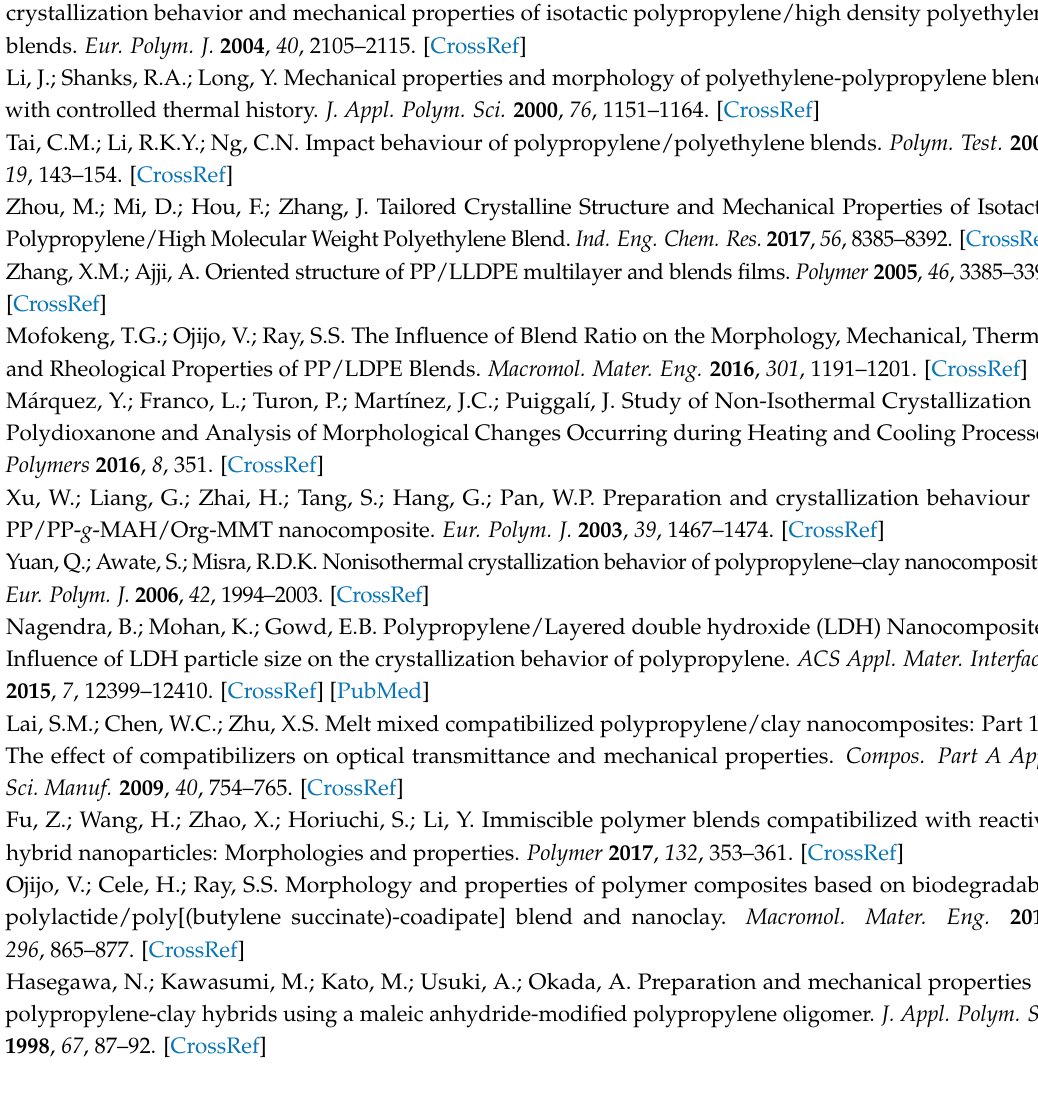
Figure S1: ln[ − ln(1 − X T )] versus ln φ plots for: (a) neat blend and (b–e) blend composites. Figure S2: Determination of the activation energy, ∆ E describing the nonisothermal crystallization process of PP in neat PP, blend, PP containing binary and ternary composites. Figure S3: TEM micrographs of binary PP/LDPE/PP- g -MA/PE- g -MA/clay composites. Figure S4: Determination of the activation energy, E